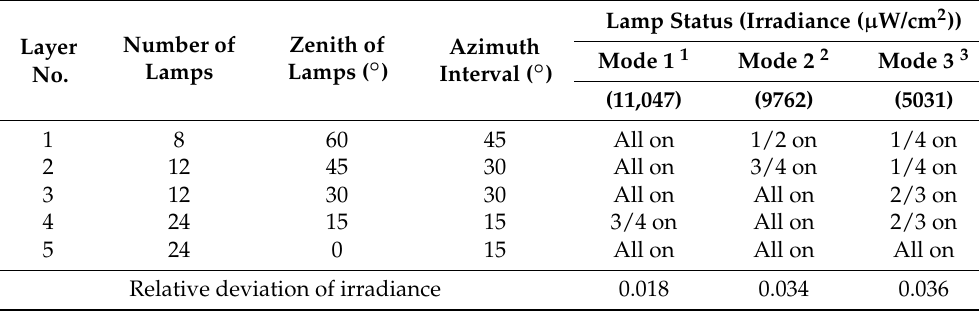
Table 8. The design of the lamp array with different working